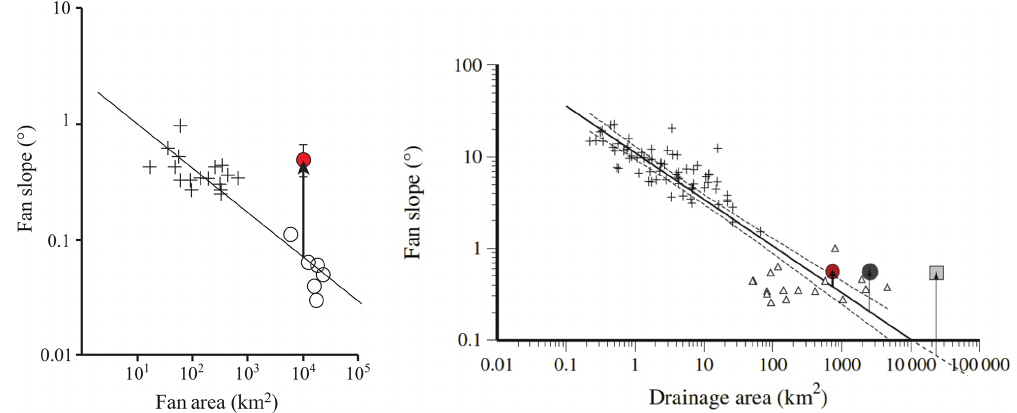
Figure 9. (a) Scaling relationship between fan area and fan slope for alluvial systems of the Alps, the Andes and the Himalayas; data from Guzzetti et al. (1997; crosses) and Horton and DeCelles (2002; open circles). Thick line is the best power-law fit to the combined data: − 0 . 30) S f = 2.42 A ( . Tilt (vertical arrow) for the Lannemezan megafan (red circle) is estimated as the difference between present-day slope f and predicted slope from the power-law fit. (B) Scaling relationship between drainage area and fan slope for alluvial systems of the Alps; data from Guzzetti et al. (1997; crosses), Crosta and Frattini (2004; triangles) and Champagnac et al. (2008; black circle = Valensole, grey square = Chambaran). The Lannemezan megafan–Neste system (red circle) lies slightly out of the relation (fit: S f = 10.4 A b ( − 0 . 51 ± 0 . 05) ). Quaternary tilt (vertical arrow) of the Lannemezan megafan surface is estimated at 0.13 ◦ , the difference between present-day slope and slope predicted by the power-law fit. Modified after Champagnac et al.